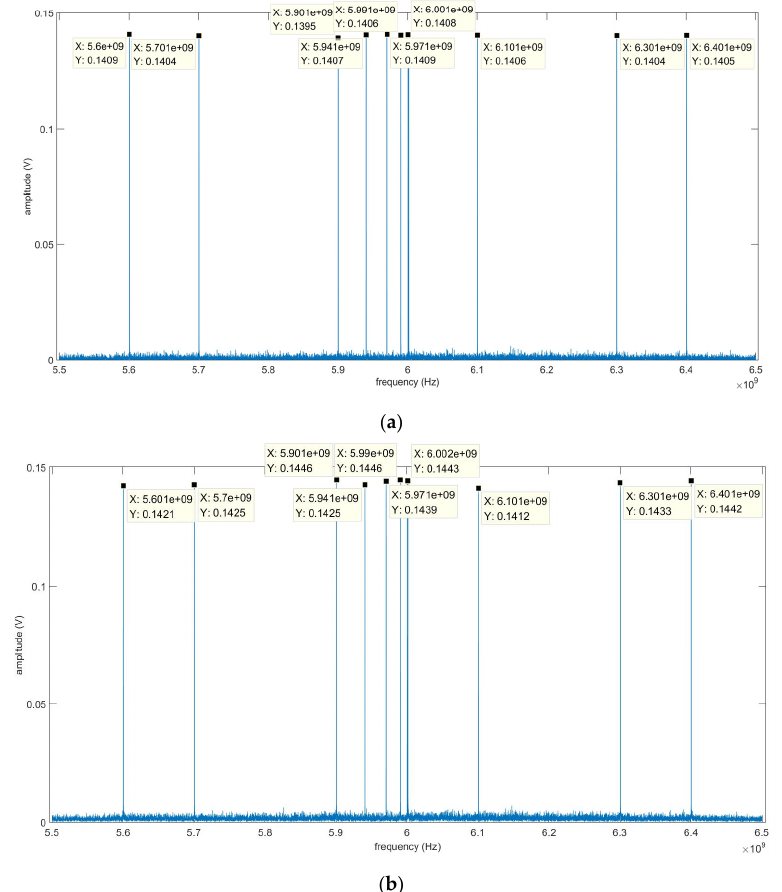
Figure 6. Output results of 11 input frequencies calculated by the classical time-domain pulse compression method ( a ) and the novel LPSA algorithm ( b ).